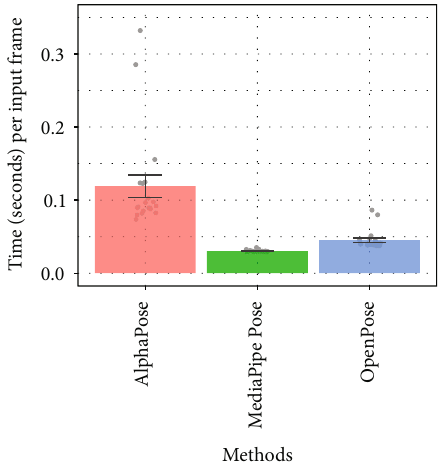
Figure 3: Mean processing time of each pose estimation method. Note: error bars indicate standard